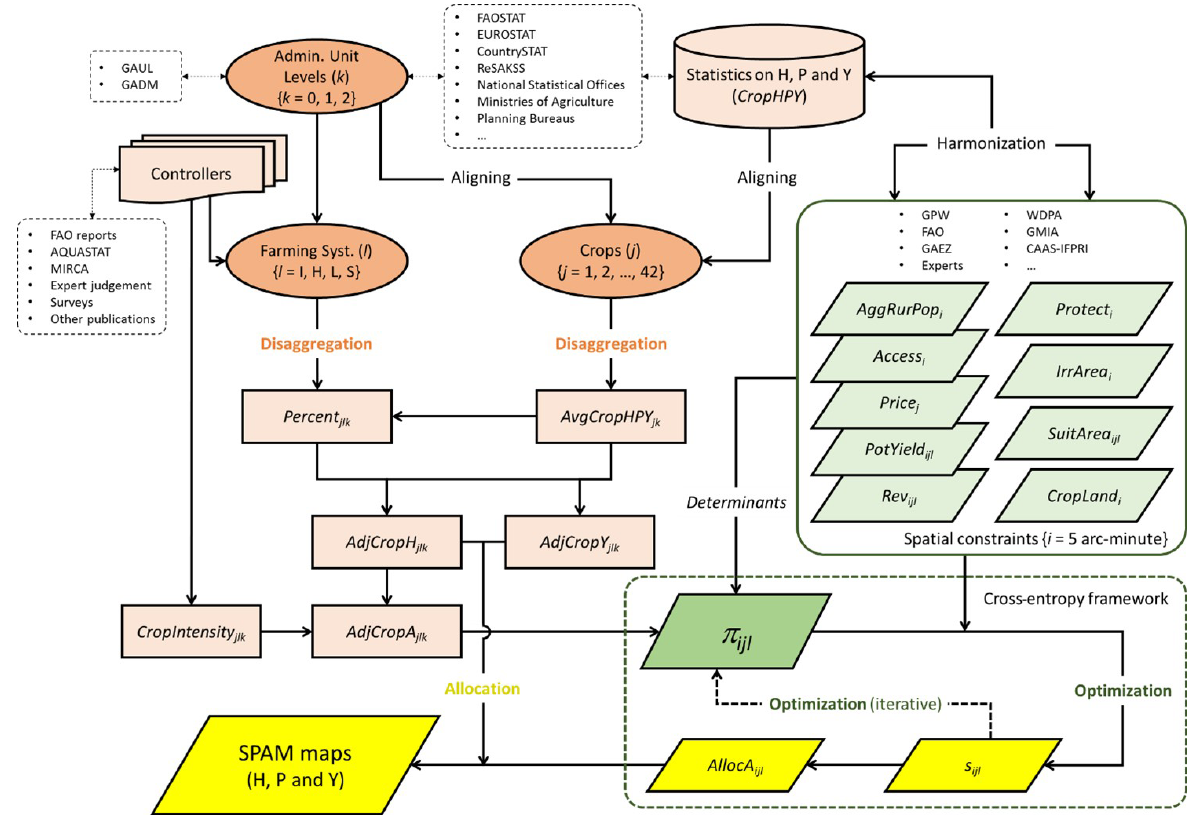
Figure 2. The overall structure of the SPAM model. The rhombuses indicate spatial data inputs and outputs, while the other shapes indicate nonspatial data inputs (see the detailed data description in the following section). The orange color indicates how crop statistics are disaggre- gated by administrative unit ( k ), crop type ( j ), and farming system ( l ). The green color indicates how the spatial parameters are collected and prepared at a unified spatial resolution ( i ) and in a harmonized manner. The yellow color indicates the spatial allocation inputs/outputs. The darker colors, either in orange or in green, highlight the essential elements in SPAM: the former indicates the farming system disaggregation scheme, while the latter indicates (i.e., priors of physical area) a key parameter with which the spatial and nonspatial data are connected and the iterative spatial allocation is able to take